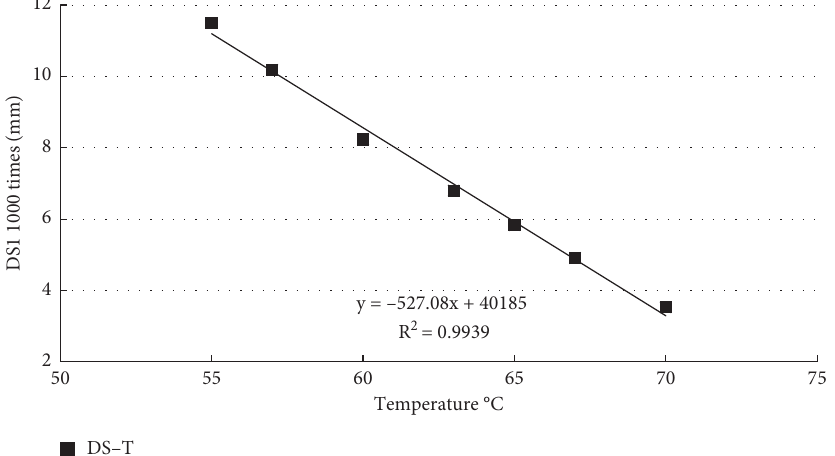
Figure 3: Relationship between DS